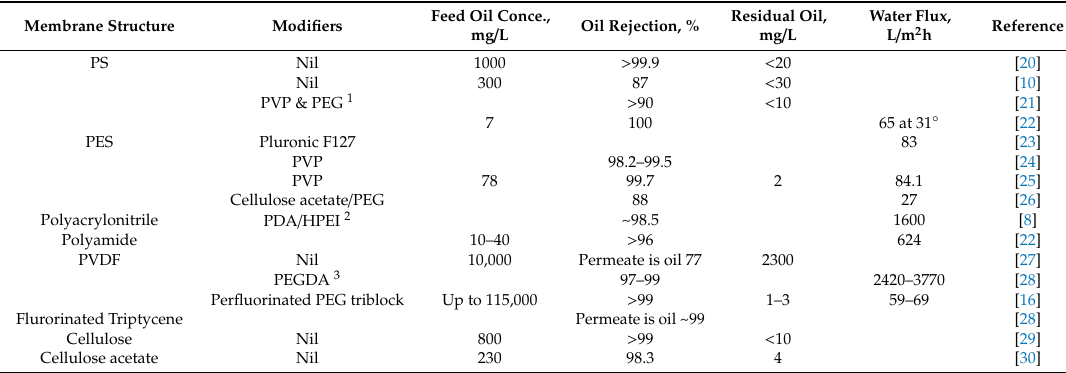
Table 1. Oil removal results using organic